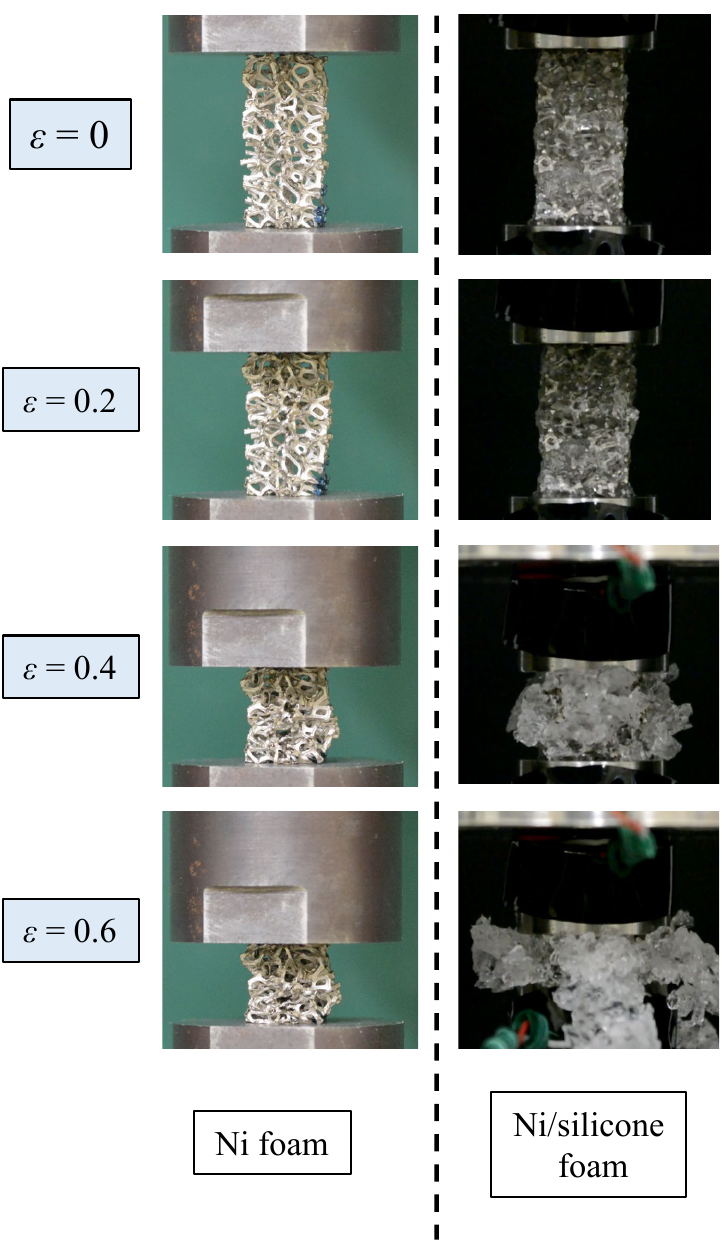
Figure 10. Deformation behavior of Ni foam and Ni/silicone foam at strain rate of 8.3 × 10 −4 s −1 .